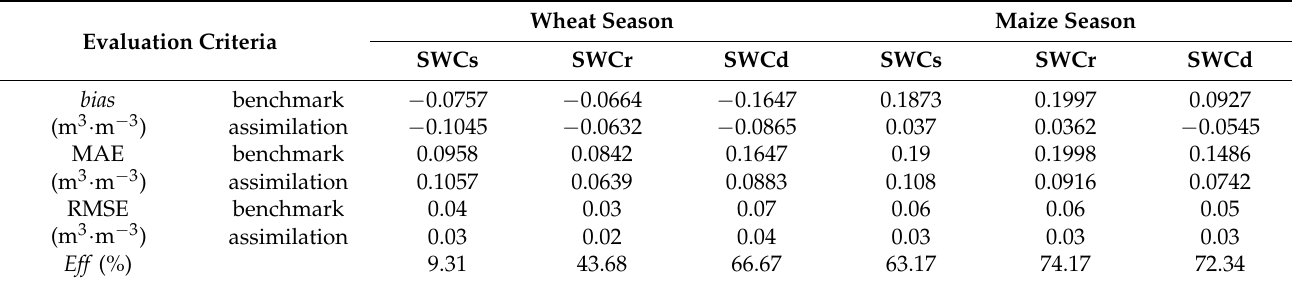
Table 5. The characteristic parameters of SWC at Weishan flux station.